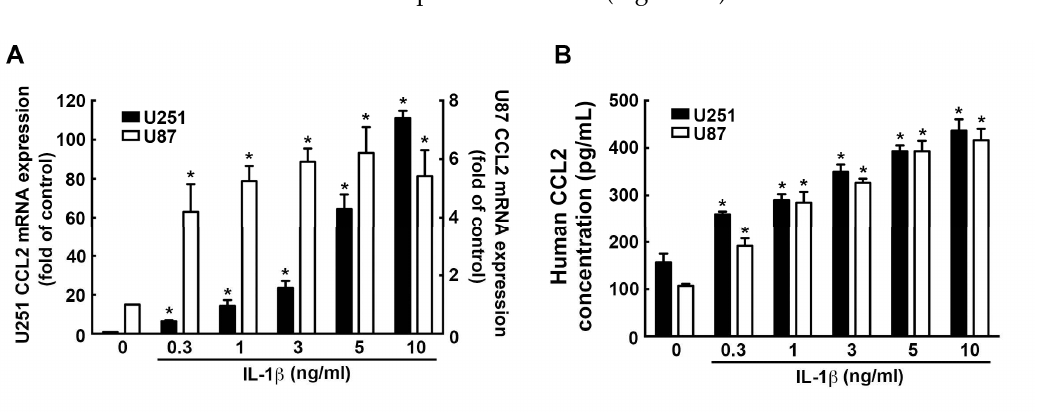
Figure 5. Upregulation of CCL2 expression induced by IL-1 β in GBM. Cells were treated with various concentrations of IL-1 β (0.3, 1, 3, 5, or 10 ng / mL) for 6 h ( A ) or 24 h ( B ), and CCL2 expression was analyzed by real-time PCR ( A ) and ELISA ( B ). One-way ANOVA followed by Bonferonni multiple comparison test was used to determine the significance of the data. * p < 0.05 compared with the control group. The data are presented as mean ± S.E.M. (representative of independent experiments = 3).